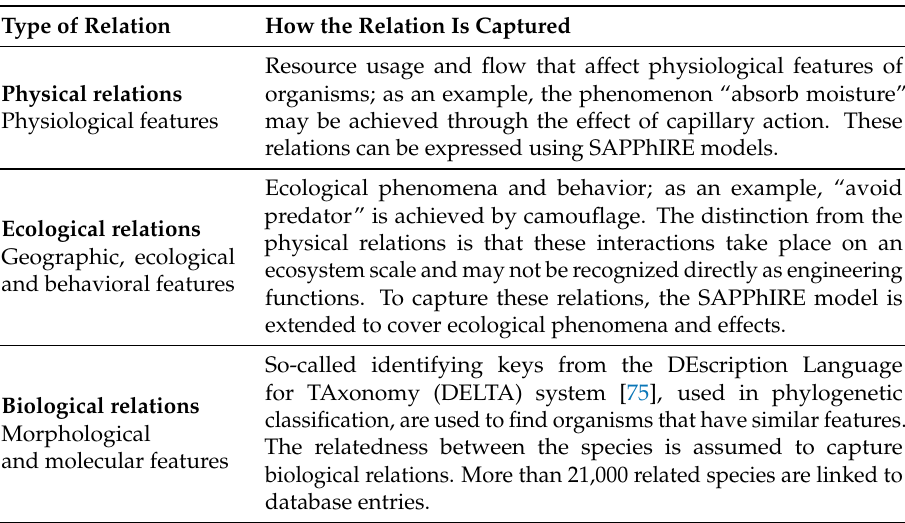
Table 5. To comprehensively capture the various relations found between system components, both internally and externally, these biological characteristics extend the usual function-based modeling approach. Adapted from Kim and Lee